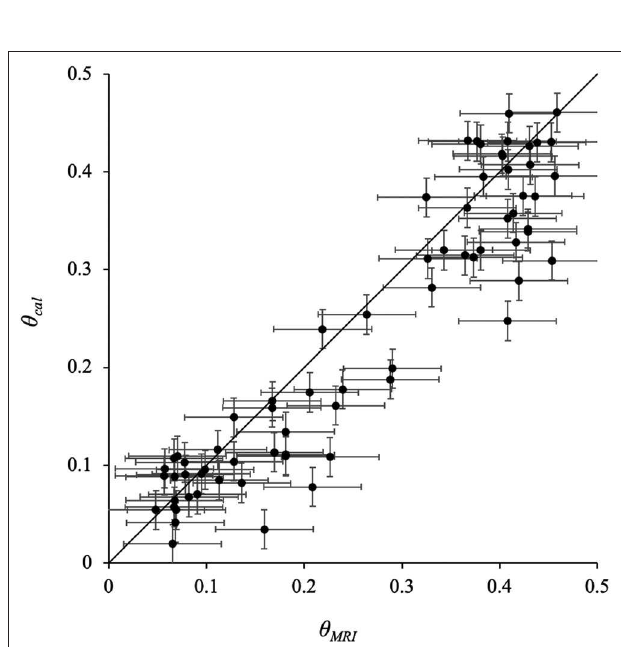
FIGURE 5 | Relationship of volumetric liquid water content between MRI method and calorimetric method. θ MRI , volumetric liquid water content measured using image of MRI; θ cal , volumetric liquid water content measured using the calorimetric method. The error range for each point is ± 0.02 on the θ cal and ± 0.05 on the θ MRI